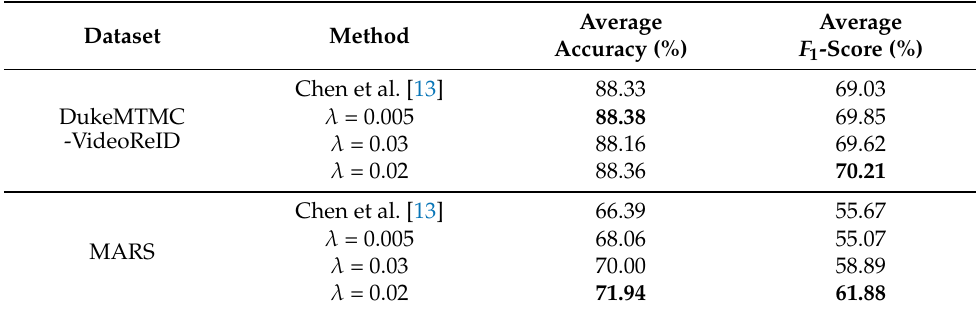
Table 4. Analysis of the group-sparsity loss for the occlusion samples of the DukeMTMC-VideoReID and MARS datasets. The bold indicates the best result.